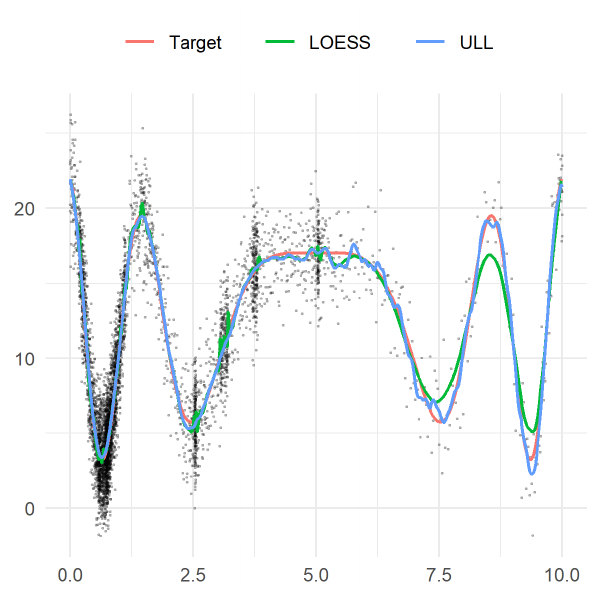
Figure 5. Example 4. Sample observations, target function, and two